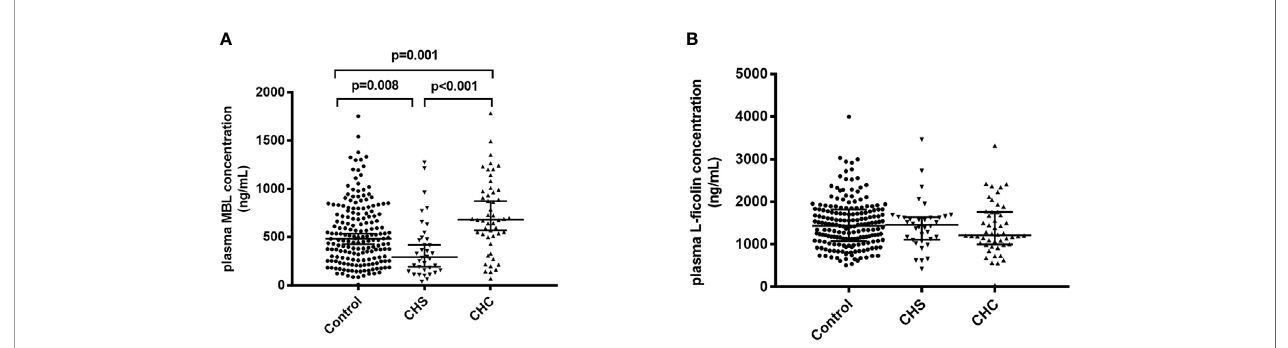
FIGURE 1 | Plasma levels of MBL (A) and L- fi colin (B) in healthy controls and in patients who spontaneously cleared HCV (CHS) and who developed chronic HCV infections (CHC).